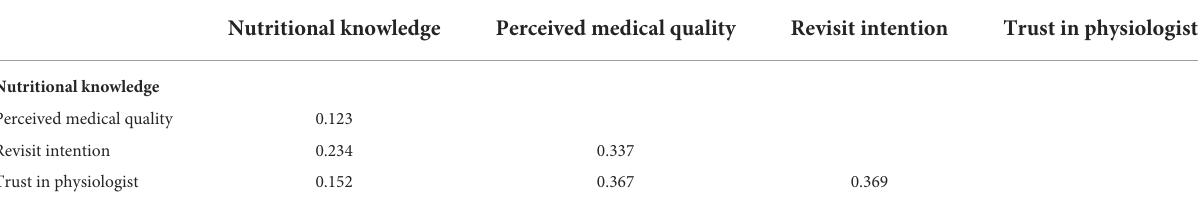
TABLE 2 Discriminant validity